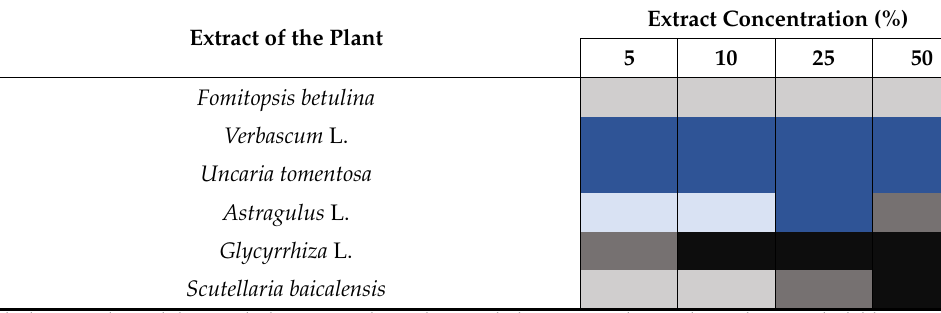
Table 4. The influence of plant extracts on B . subtilis growth. Extract of the Plant Fomitopsis betulina Verbascum L. Uncaria tomentosa Astragulus L.